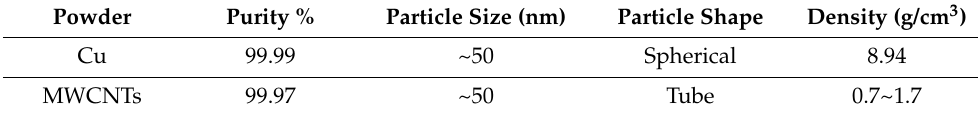
Table 1. The used materials and characteristics of Cu-MWCNTs.